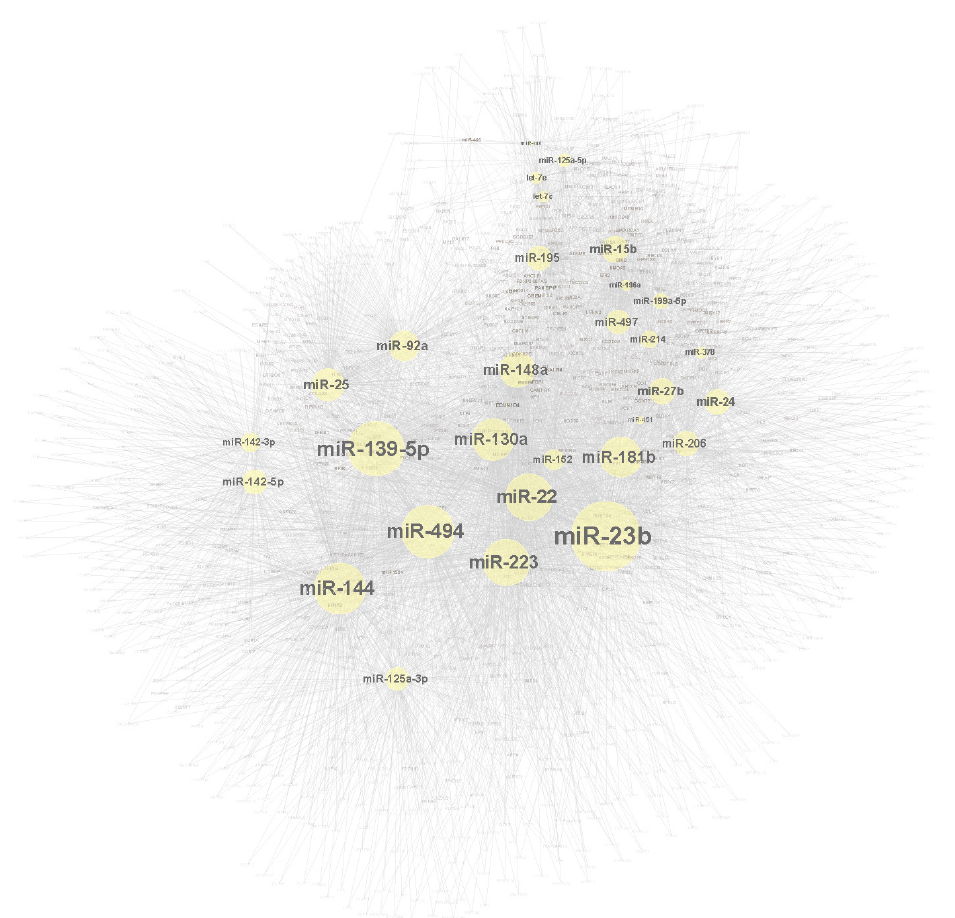
Figure 3. miRNA-target gene interactions for the significantly differentially expressed miRNAs in bone fracture healing.